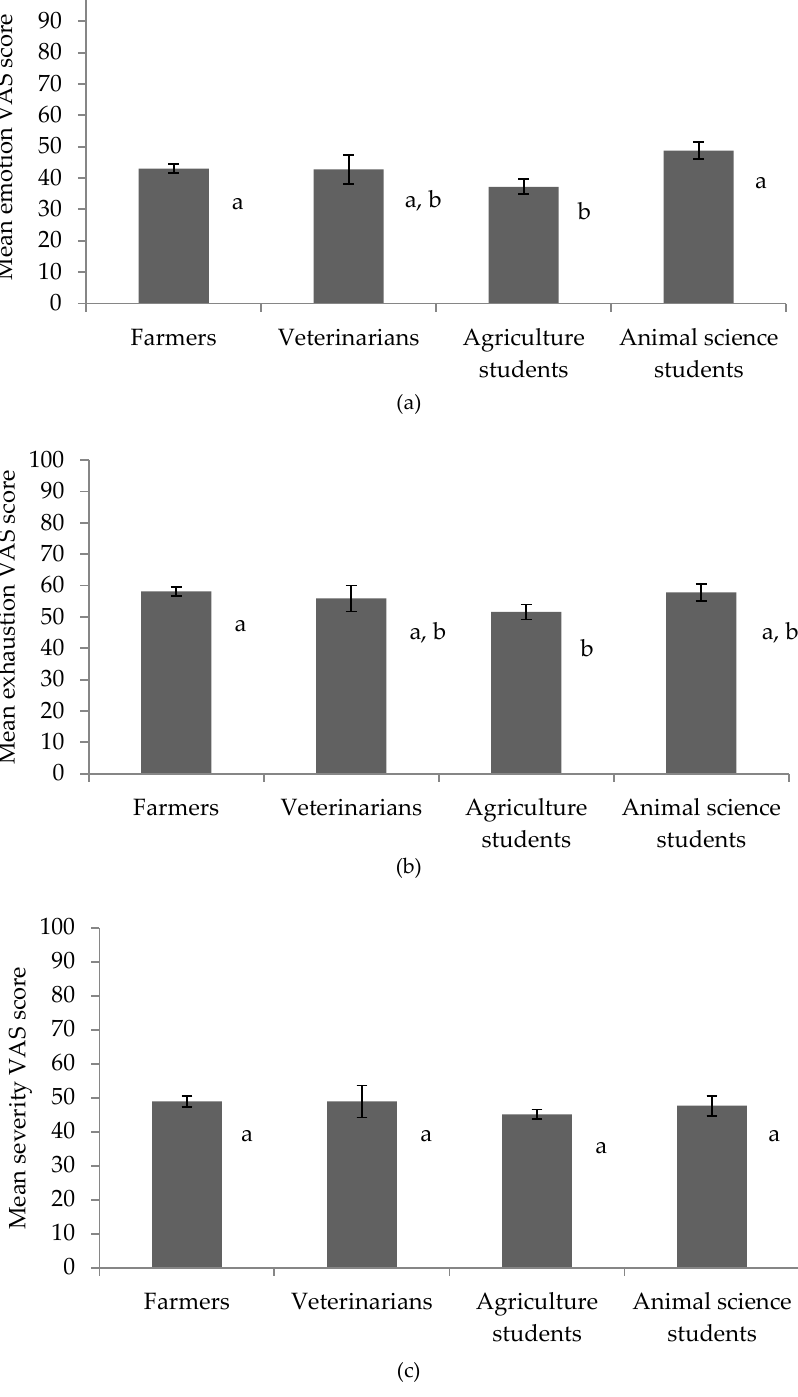
Figure 1. Mean visual analogue scale (VAS) scores for ( a ) emotion, ( b ) exhaustion, and ( c ) severity according to occupation; whereby occupations with different letters express a significant difference in mean response.